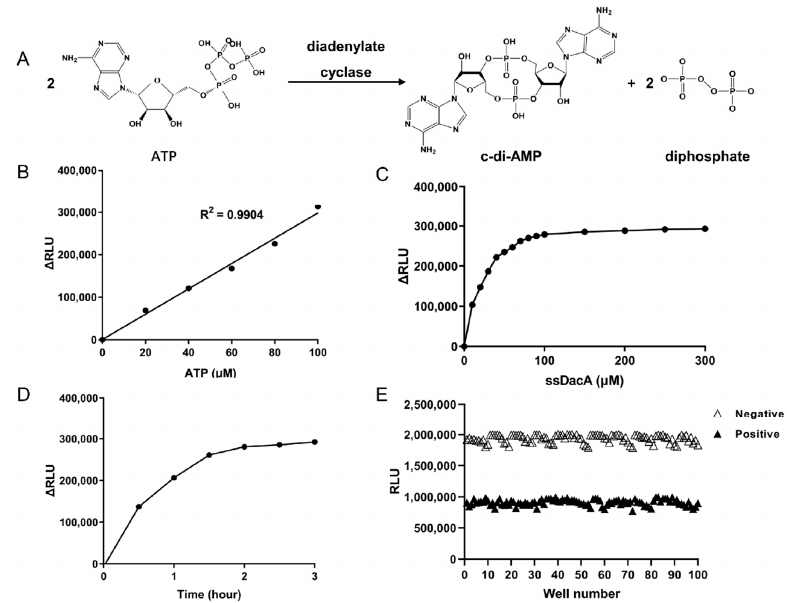
Figure 2. Optimization of parameters for the enzymatic reaction of ssDacA. ( A ) Biochemical reaction of diadenylate cyclase; ( B ) determination of the optimal ATP concentration. A reaction mixture